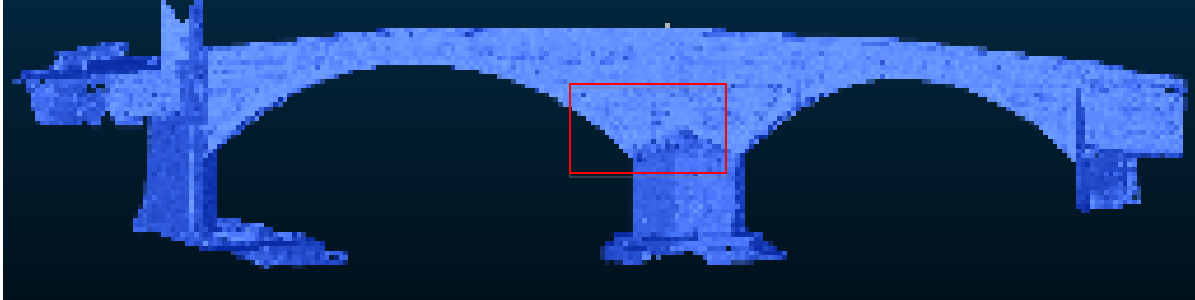
Figure 4 – 3D mesh of the bridge obtained from point cloud by applying the following parameters: Octree depth =14, Samples per node =4, Full depth =8, Point weight =12, Boundary=